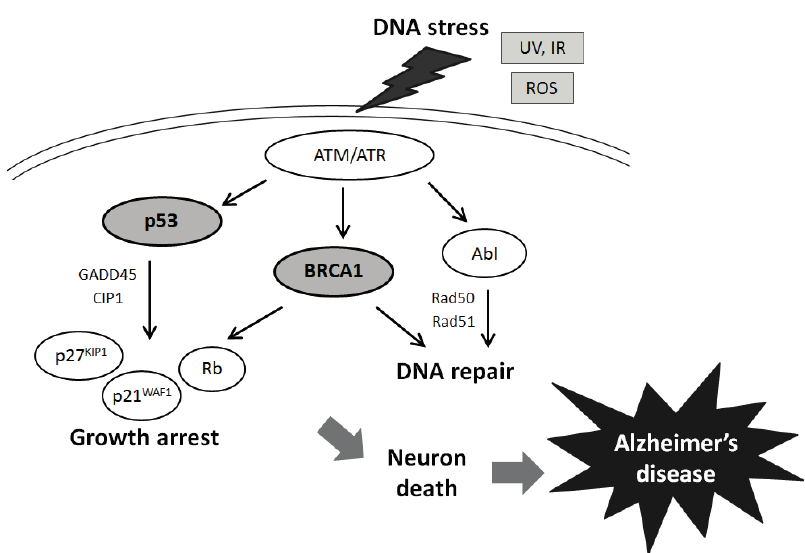
Figure 1. Schematic illustration of tumor suppressor signaling including BRCA1, p53,